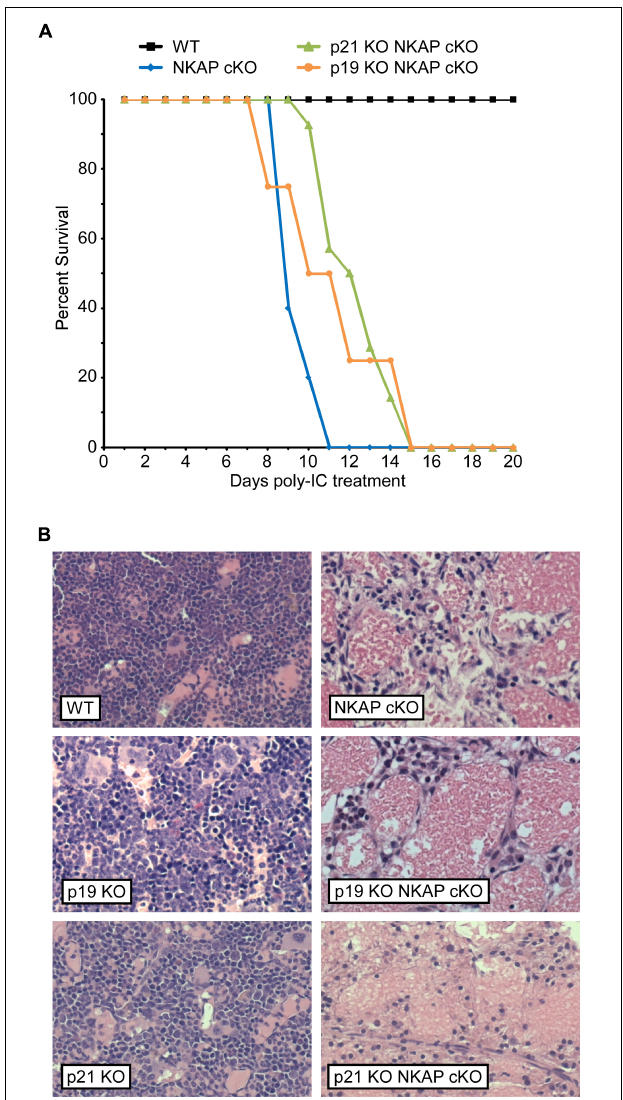
FIGURE 1 | NKAP deficiency results in lethality and hematopoietic failure. (A) Survival was examined in 3 WT, 7 Mx1-cre NKAP cKO, 14 p21